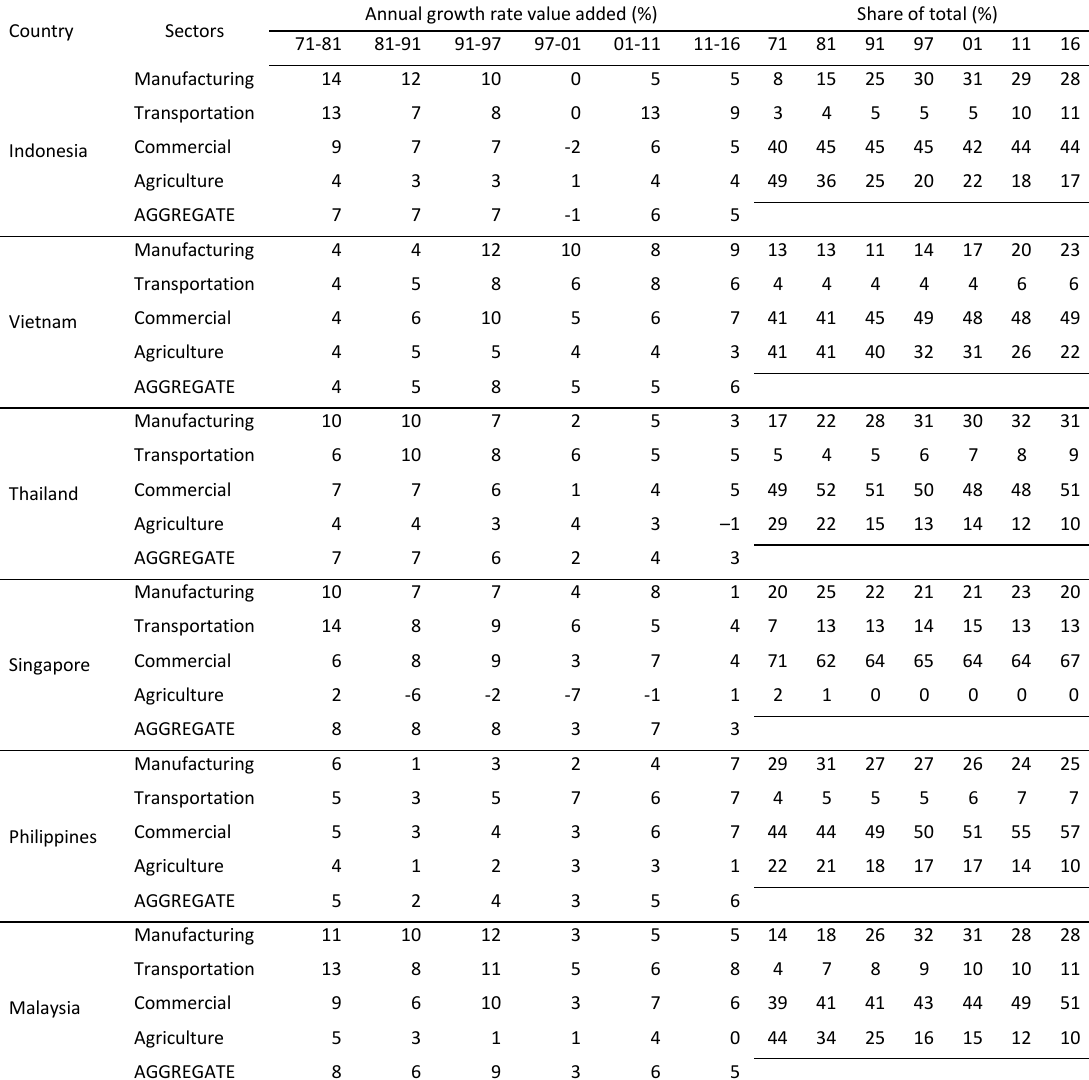
Table 1: Gross value-added shares and annual growth rate of